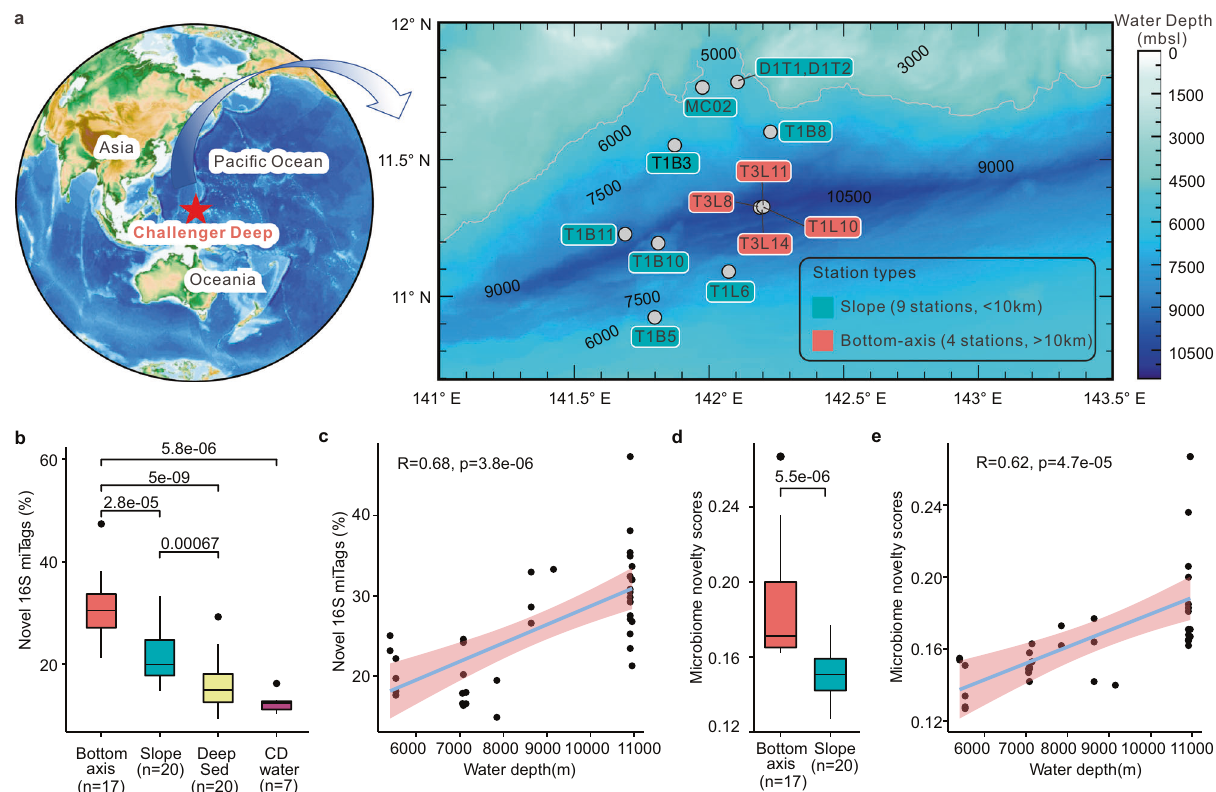
Fig. 1 Overview of sampling sites and microbiome novelty in Challenger Deep (CD) sediments. a Sampling locations in CD (details of the sampling sites are in Supplementary Data 2). b Box plots showing the average percentage of novel 16S miTags in slope and bottom-axis CD sediment metagenomes (this study), deep-sea hydrothermal/cold-seep sediment metagenomes (Deep Sed), and CD hadal water column (CD water) metagenomes from public databases ( p values were estimated using the two-sided Wilcoxon test for pairwise comparisons). Sequences and identity results are deposited in https:// doi.org/10.6084/m9. fi gshare.12979709. c Pearson ’ s correlation analyses between the estimated novel 16S miTags and the different depths of the sampling sites ( p value was calculated using the two-sided t test). d Microbiome novelty scores (MNS) for CD slope and bottom-axis sediments ( p values estimated using the two-sided Wilcoxon test). e Pearson ’ s correlation analyses between the microbiome novelty scores and the different depths of the sampling sites ( p values were calculated using the two-sided t test). In box plots ( b , d ), center lines indicate median values. The lower and upper bounds represent 25th and 75th percentiles, respectively. The lower/upper whiskers represent minima/maxima no further than 1.5 times the interquartile range from the hinge, and the points falling outside of the whiskers represent the outliers. The pink background at c , e indicates 95% con fi dence interval. Source data are provided as a Source data fi